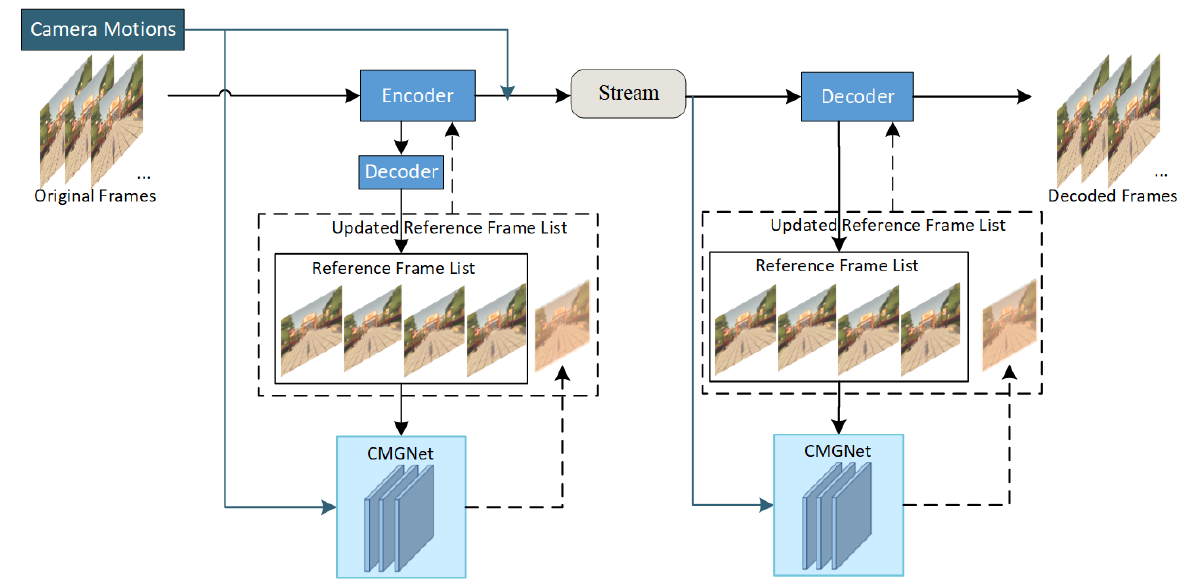
Figure 2. Overview of the proposed optimization compression